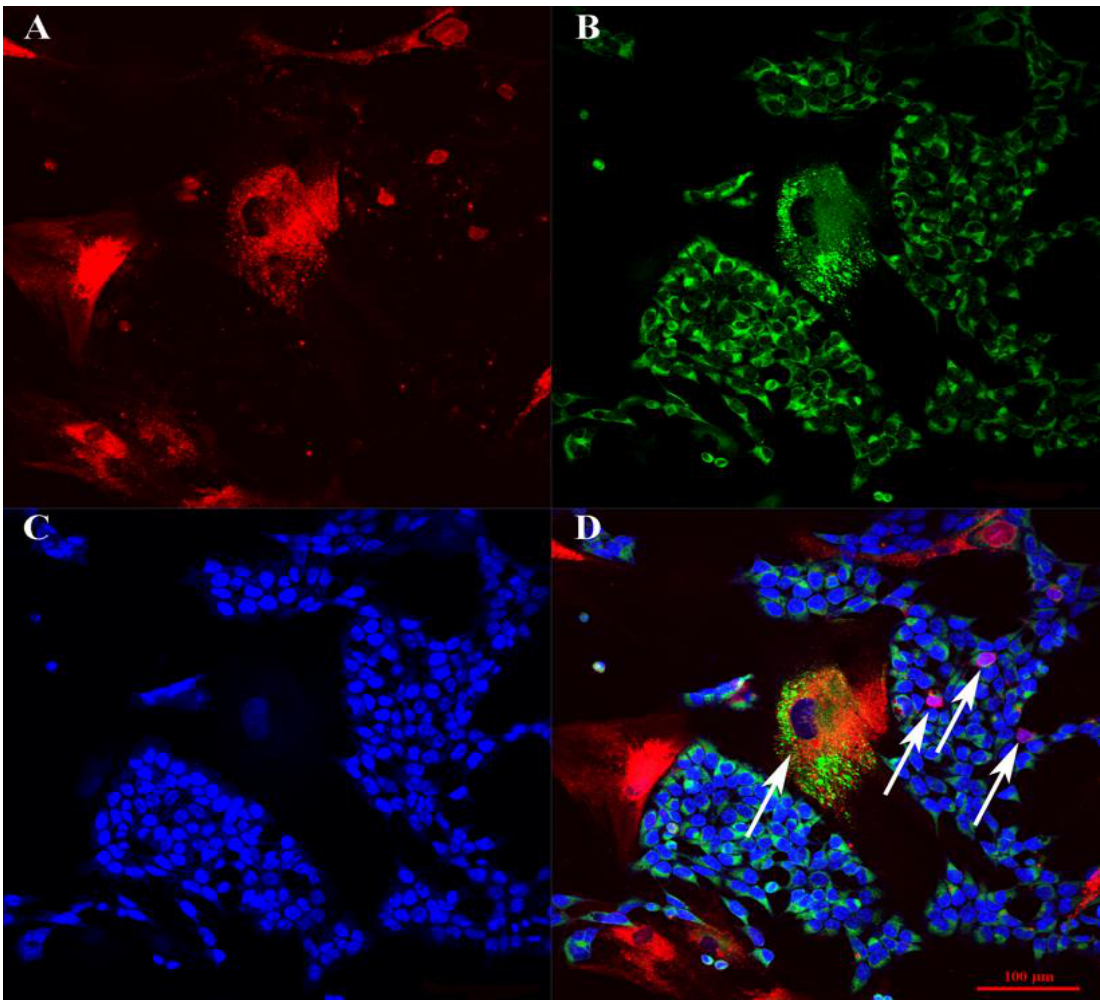
Figure 4. The confocal microscopy BM-MSCs and SH-SY5Y cells on glasses. ( A ) Channel filtered for the emission spectrum of Alexa Fluor 647. ( B ) Channel filtered to gather fluorescence emission from Alexa Fluor 488. ( C ) Channel filtered for the emission spectrum of Alexa Fluor 460. ( D ) Merge. Arrows indicate the cells that have mixed colors as a result of membrane and cytoplasmic exchange between cells.